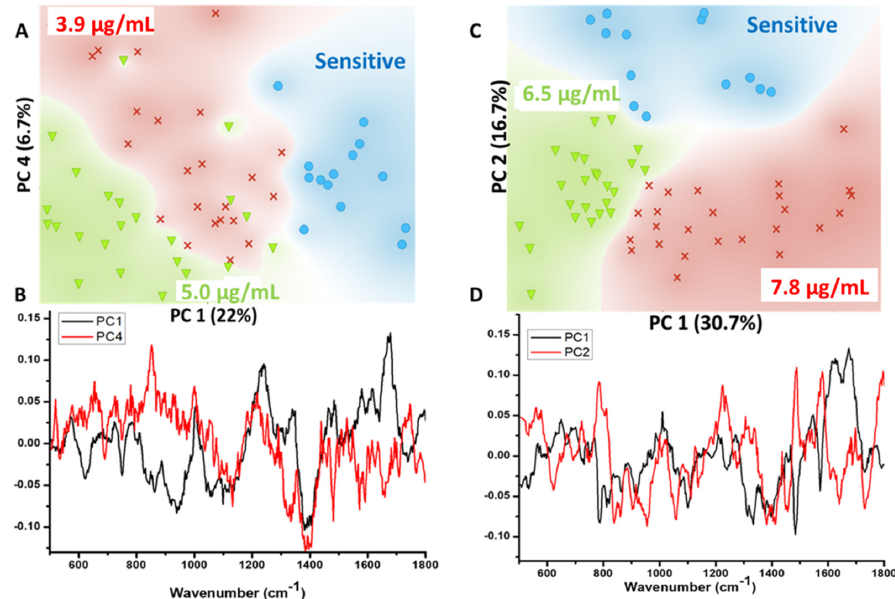
Figure 5. ( A ) PCA-scatter plot between sensitive and cells resistant to colistin concentration of 3.9 and 5 µg/mL ( B ) Loading plot of PC1- and PC4 used for classification. ( C ) PCA-scatter plot between sensitive and cells resistant to colistin concentration of 6.5 and 7.8 µg/mL ( D ) Loading plot of PC1- and PC2 used for classification.